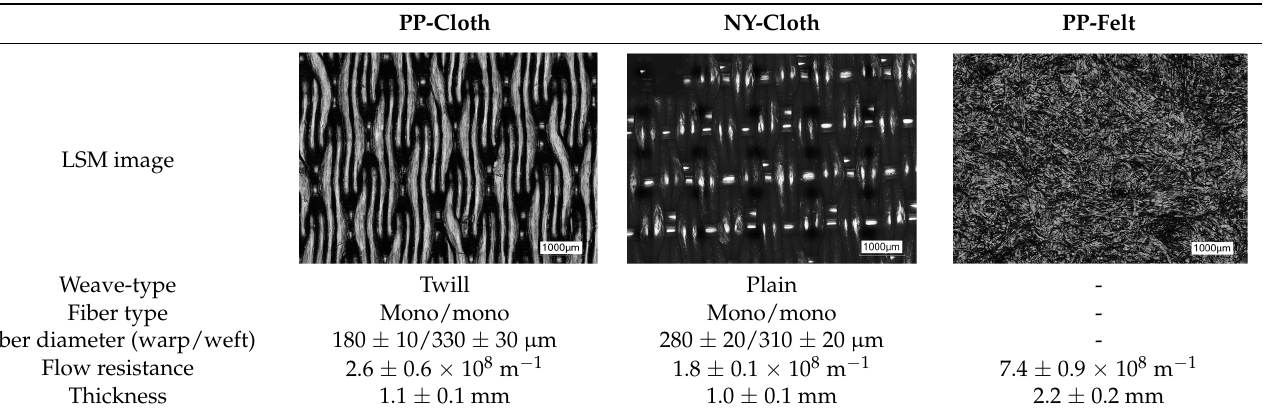
Figure 5. Point of rupture for the thin nylon cloth clamped over a circular edge geometry.